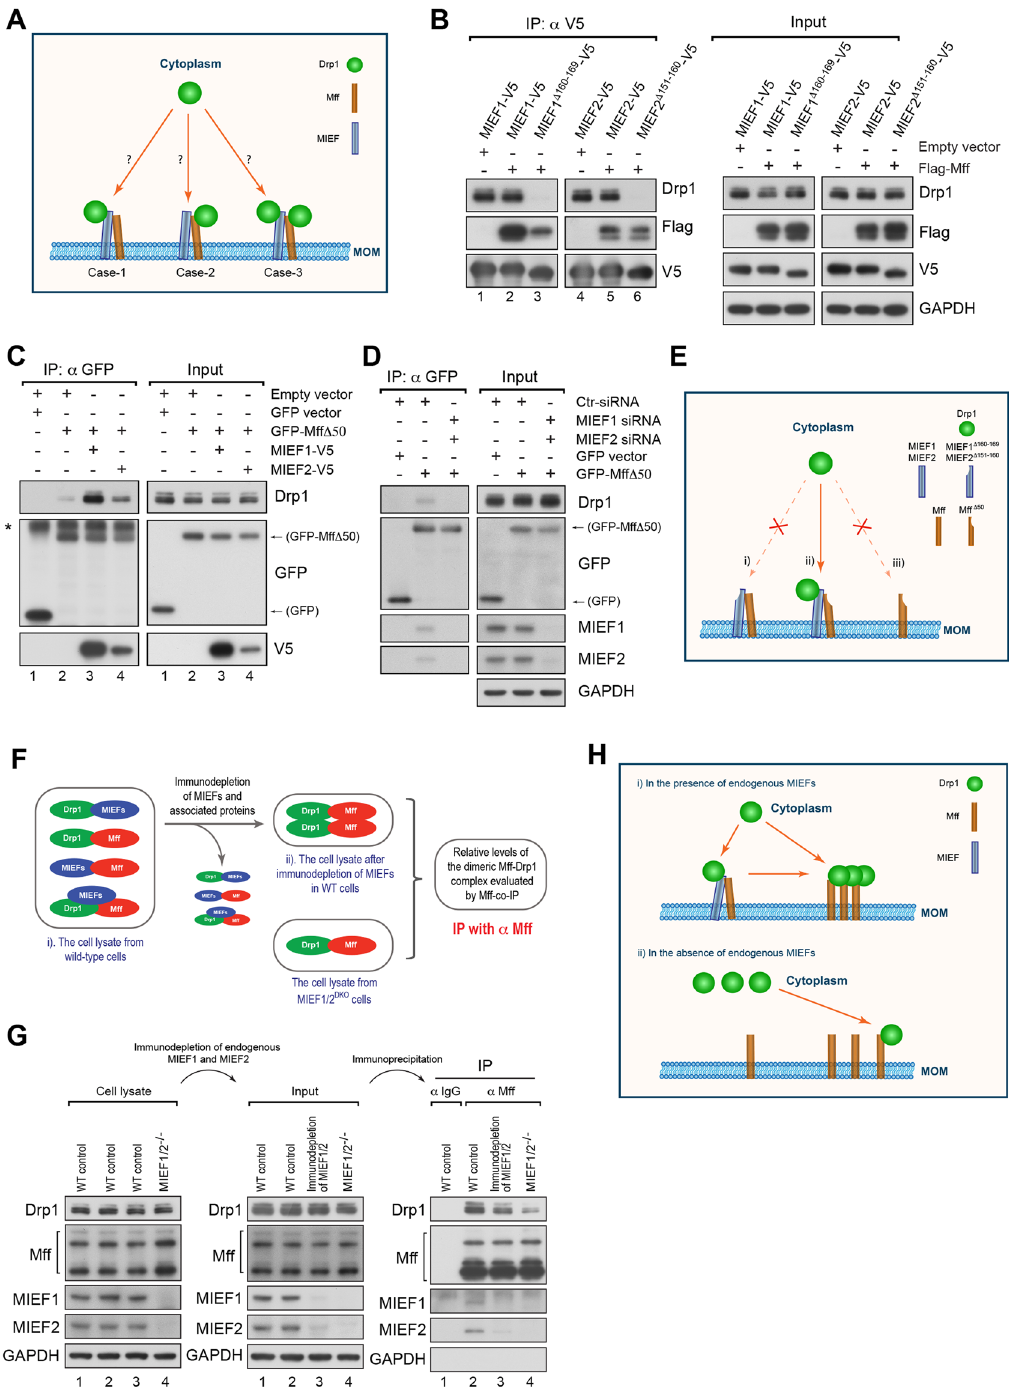
Figure 6. MIEF acts as an adaptor linking Drp1 and Mff in a trimeric Drp1-MIEF-Mff complex. ( A ) A schematic diagram for three possible Drp1 assembly modes in a trimeric Drp1-MIEF-Mff complex on mitochondria. Case-1: Drp1 binds only to MIEF; Case-2: Drp1 binds only to Mff; Case-3: Drp1 binds to both MIEF and Mff. MOM: mitochondrial outer membrane. ( B ) Drp1 is unable to bind Mff in the Drp1- MIEF-Mff complex. 293T cells were co-transfected with indicated plasmids. MIEF1 Δ 160–169 and MIEF2 Δ 151–160 represent Drp1 binding-deficient MIEF mutants. Cell lysates were used for co-IP with anti-V5 beads followed by immunoblotting with indicated antibodies. ( C ) Drp1 interacts with MIEF in the trimeric Drp1-MIEF-Mff complex. 293T cells were co-transfected with empty vector and GFP vector, or with GFP-Mff ∆ 50 (a Drp1 binding-deficient Mff mutant) together with empty vector, MIEF1-V5 or MIEF2-V5 plasmid as indicated. Cell lysates were used for co-IP with anti-GFP beads followed by immunoblotting with indicated antibodies. * Represents IgG heavy chain. ( D ) Drp1 is brought to the Mff ∆ 50-associated complex via endogenous MIEF. 293T cells were treated with control, or MIEF1 plus MIEF2 siRNAs, and then transfected with